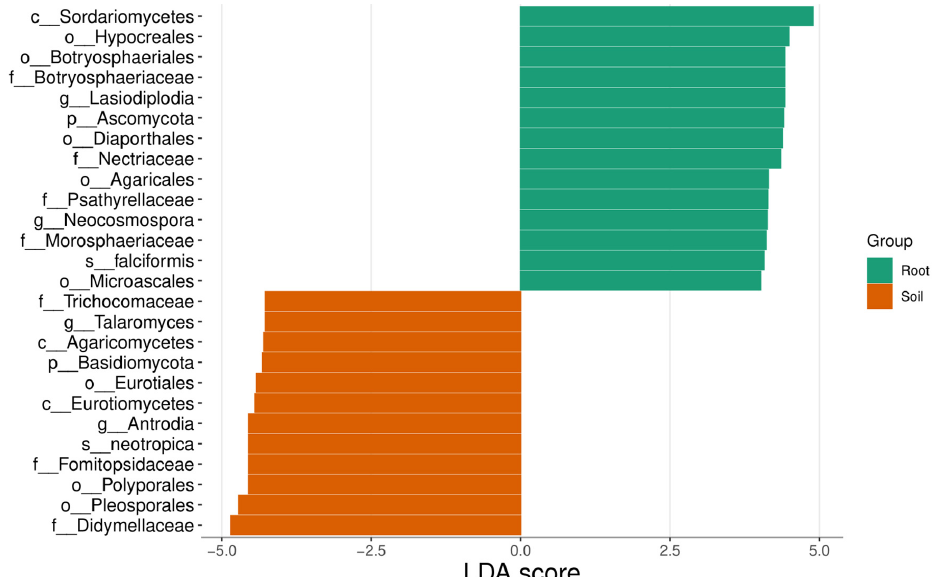
Figure 8. Lefse analysis of cocoa soil and roots. LDA shows different fungal taxa differentially significant at p < 0.05 (LDA cutoff =